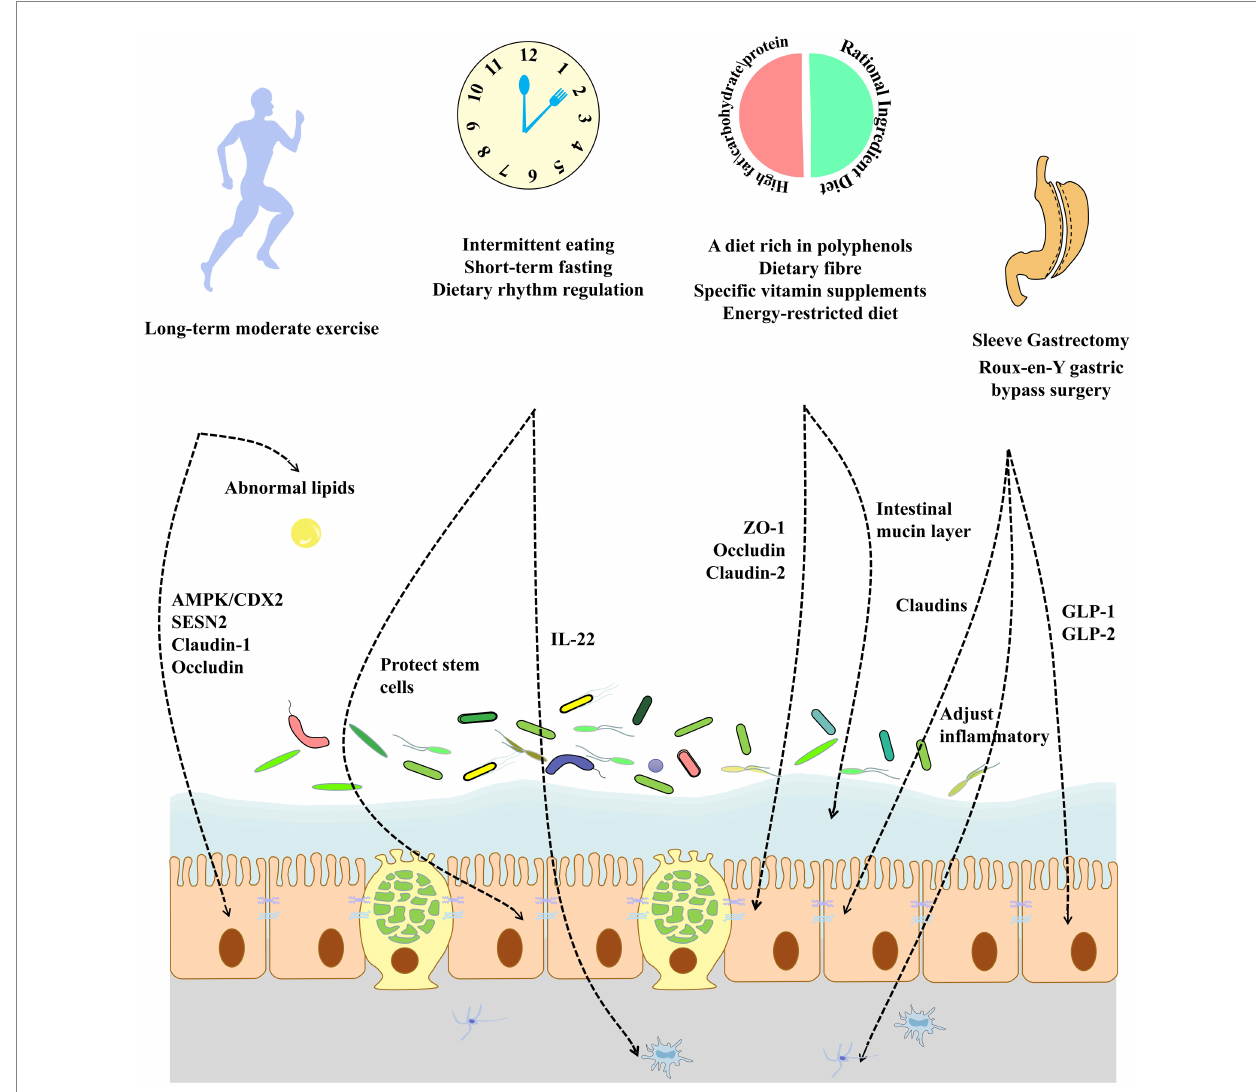
FIGURE 3 An unhealthy lifestyle and diet can play an important role in the development of metabolic diseases by affecting the intestinal barrier. Exercise over the long-term improves intestinal tight junction protein expression and ameliorates abnormal lipids in the gut. The modulation of dietary rhythms can improve intestinal stem cell function, alleviate chronic inflammation, and improve the intestinal barrier. The modification of the dietary composition increases tight junction protein expression while improving the intestinal mucus barrier. Bariatric surgery in obese patients can adjust intestinal inflammatory and inflammation and increase the secretion function of intestinal epithelial cells by increasing the expression of intestinal tight junction